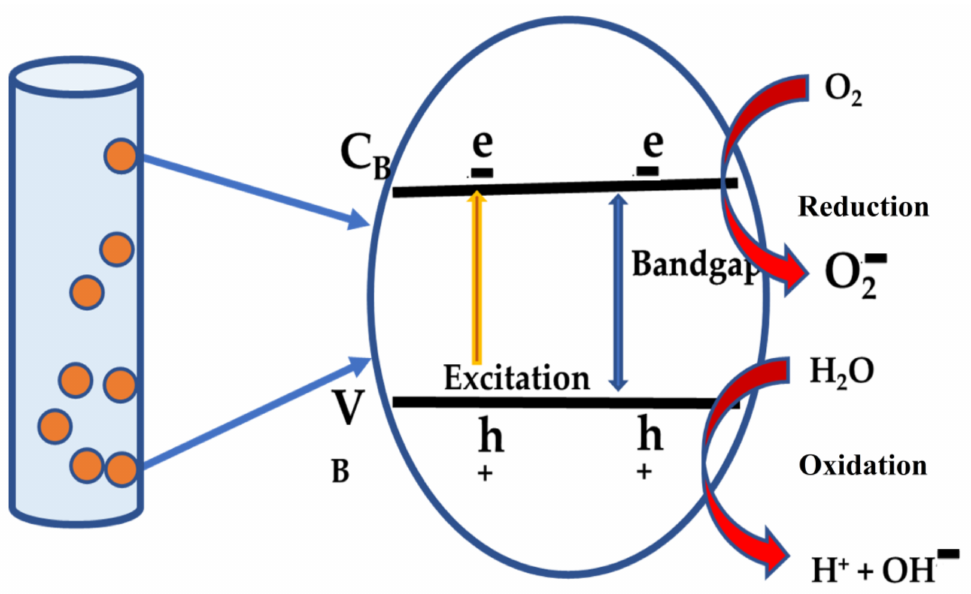
Figure 15. HC/ZnONC mediated photocatalytic degradation mechanism of MB dye